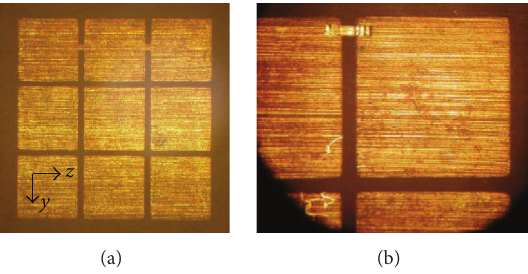
Figure 6: Photos of the fabricated antenna samples fragments. (a) is the sample with fabricated interconnections for 𝑝 = 0.5 mm. (b) is the sample with ribbon bonding connection for 𝑝 = 0.1 mm. The antenna total substrate size is 20mm by 40